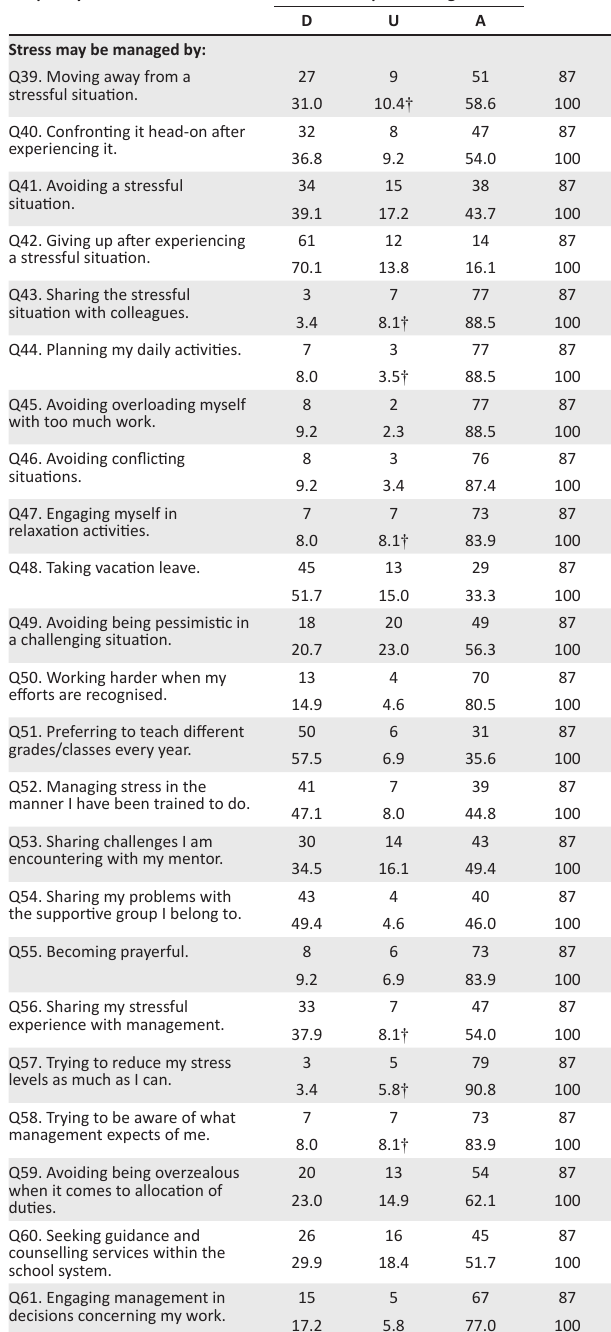
TABLE 4: Management of stress ( n = 87). Frequency table Perception